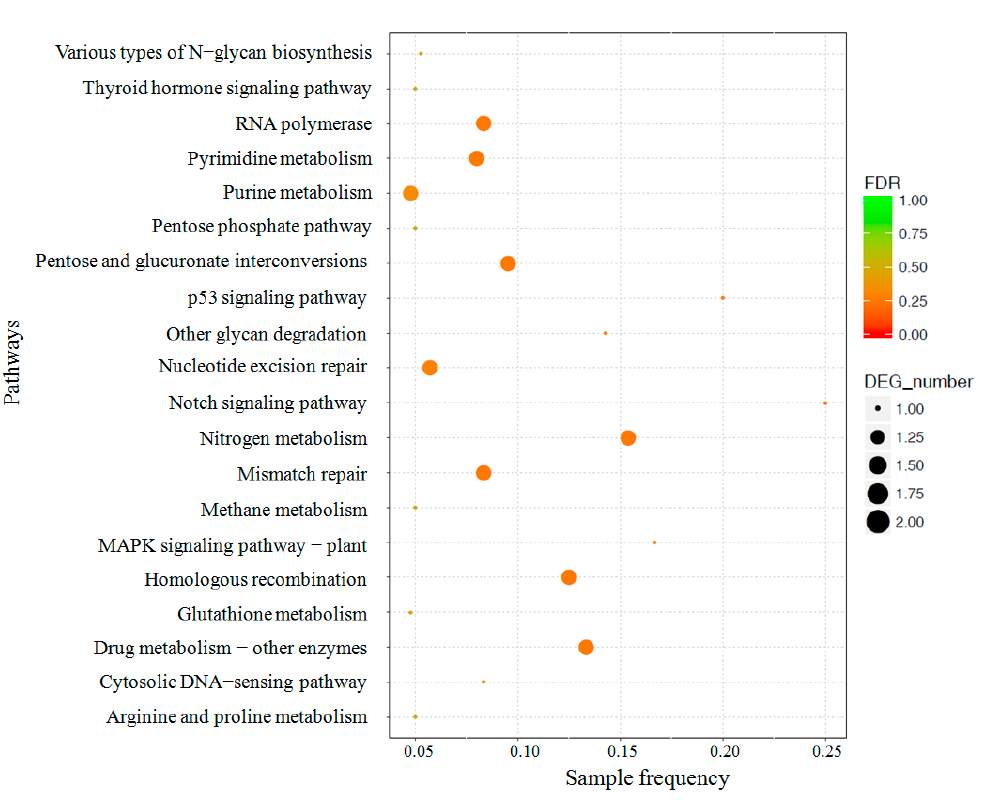
Figure 5. The top 20 enriched KEGG pathways of differentially expressed genes between immature mycelia and mature mycelia. ‘Sample frequency’ means the ratio of the number of differentially expressed genes in a pathway to the number of all annotated genes in this pathway in the figure legend. DEG number indicates the number of differential genes annotated in the pathway, indicated by a dot, the larger the dot, the more differential genes are enriched. The color gradient indicates the corrected p -value by Benjamini–Hochberg FDR method. Only pathways with FDR <1 were shown.